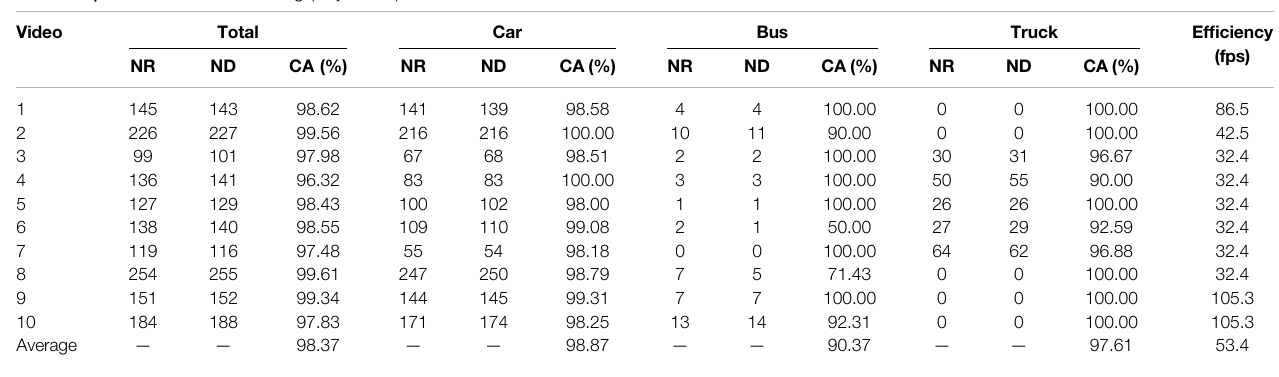
TABLE 6 | Results of vehicle counting (Tiny-YOLO).